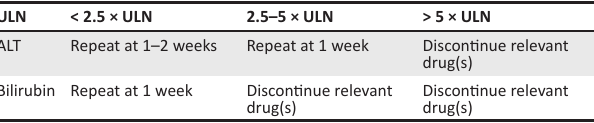
TABLE 14: Guidelines for managing hepatotoxicity: Elevation. ULN < 2.5 × ULN > 5 × ULN ALT Repeat at 1–2 weeks Repeat at 1 week Discontinue relevant drug(s) Bilirubin Repeat at 1 week Discontinue relevant Discontinue relevant drug(s)